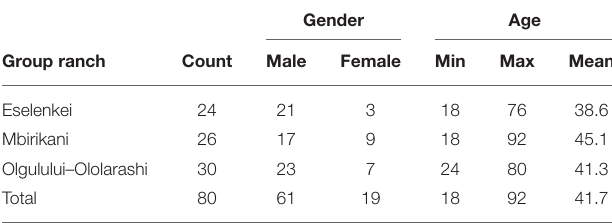
TABLE 2 | Profile of the 80 participants in the questionnaire-based interviews. Gender